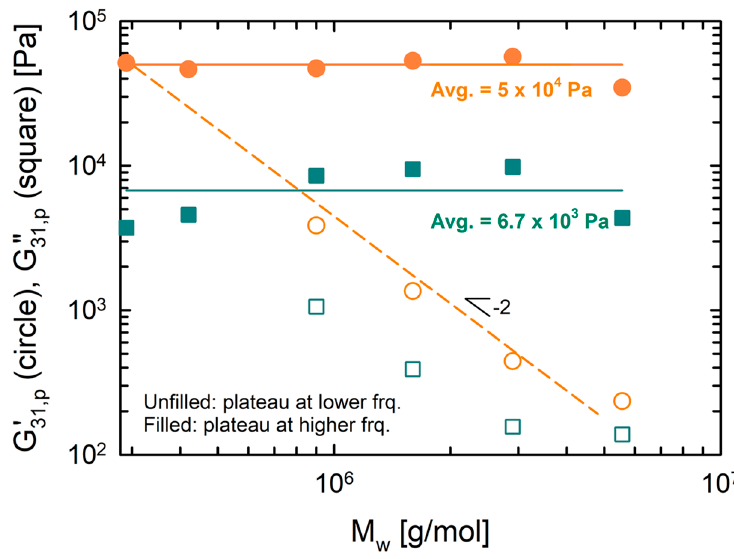
Figure 5. First-harmonic medium amplitude oscillatory shear (MAOS) moduli ( 𝐺 (cid:2871)(cid:2869)(cid:4593) and 𝐺 (cid:2871)(cid:2869)(cid:4593)(cid:4593) ) of model comb PS set at T ref = 180 °C. All values are negative. Moduli were shifted vertically for clarity of presentation.